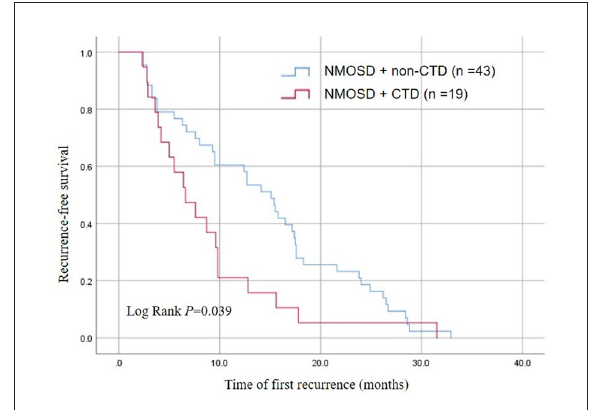
FIGURE2 Kaplan-Meier analysis demonstrating the cumulative proportion of recurrent patients without relapse in the NMOSD + non-CTD group and the NMOSD + CTD group.